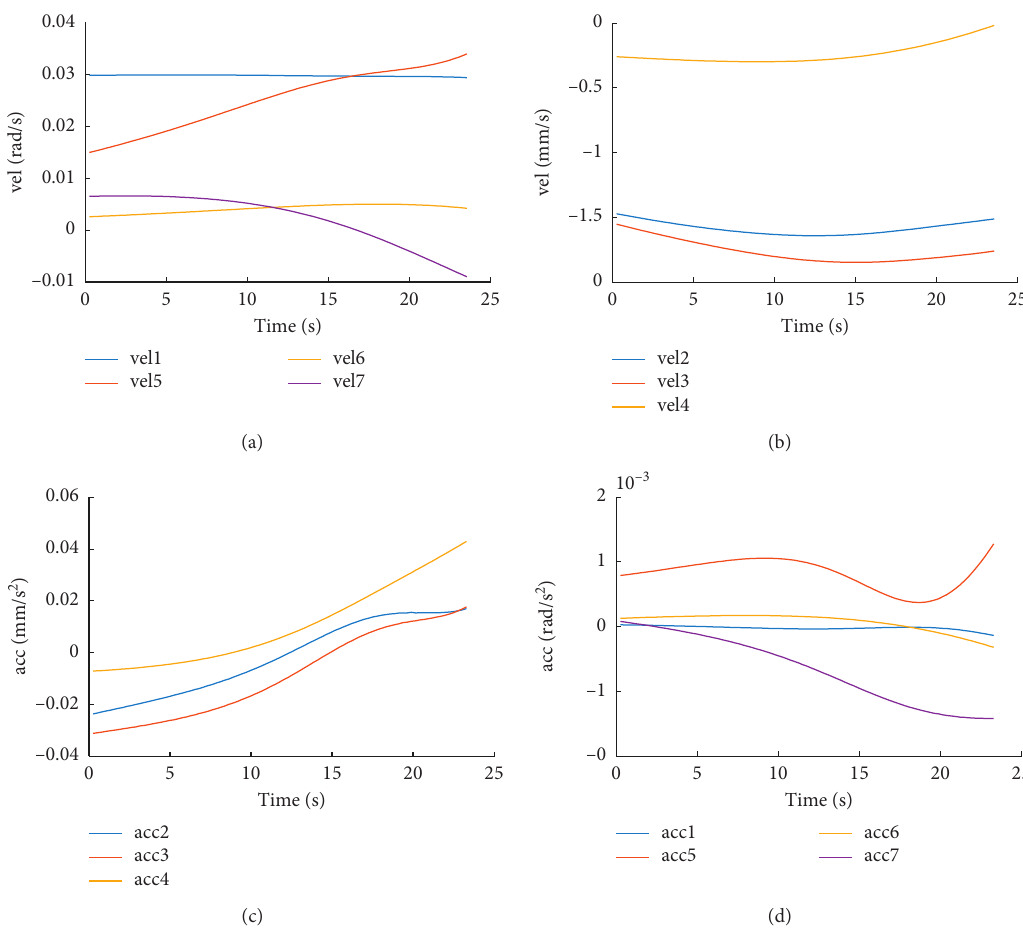
Figure 7: The angular velocity and angular acceleration curves of the second manipulator when Z � 0. vel1–vel7 represent the velocity of joints 1–7, respectively. acc1–acc7 represent the acceleration of joints 1–7,